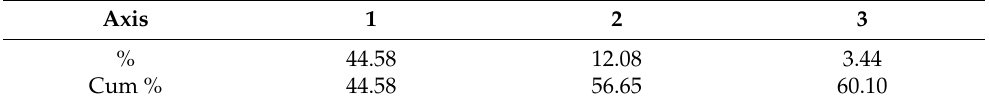
Table 5. PCoA analysis of wheat varieties. Axis